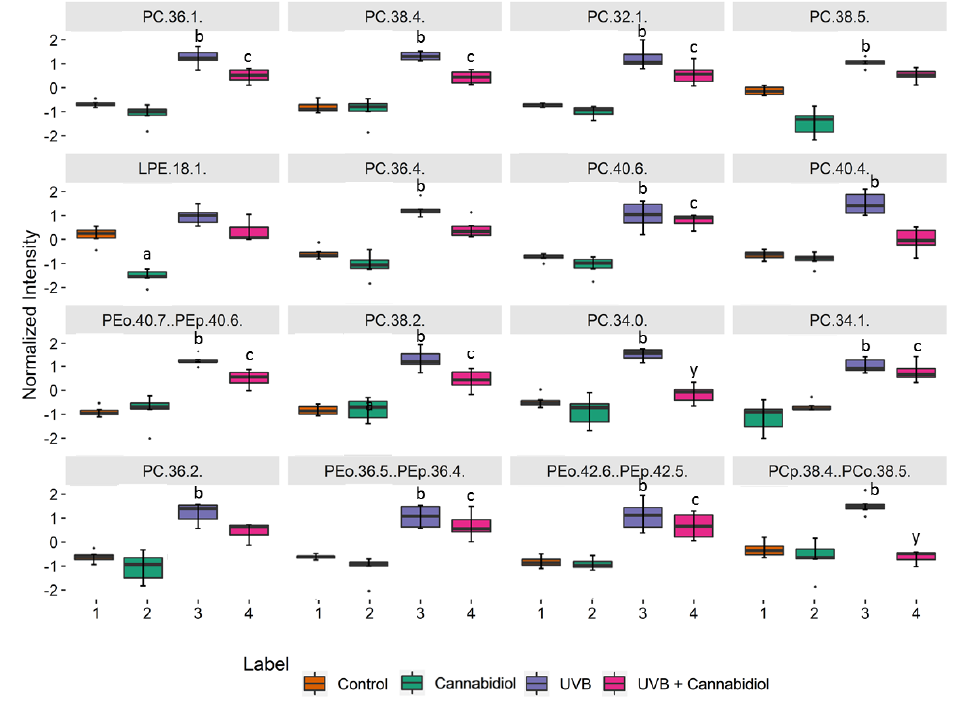
Figure 4. Boxplots of the 16 most discriminating PL molecular species (according to Kruskal–Wallis and the post hoc Dunn’s multiple comparisons tests) identified in keratinocytes isolated from the skin of healthy subjects (control). These cells were not treated or treated with CBD (4 μM) or/and UVB (60 mJ/cm 2 ). The following groups of keratinocytes were examined: Control, CBD, UVB, and UVB + CBD; p < 0.05 was considered statistically significant: a , control vs. CBD; b , control vs. UVB; c − control vs. UVB + CBD; y − UVB vs. UVB + CBD.